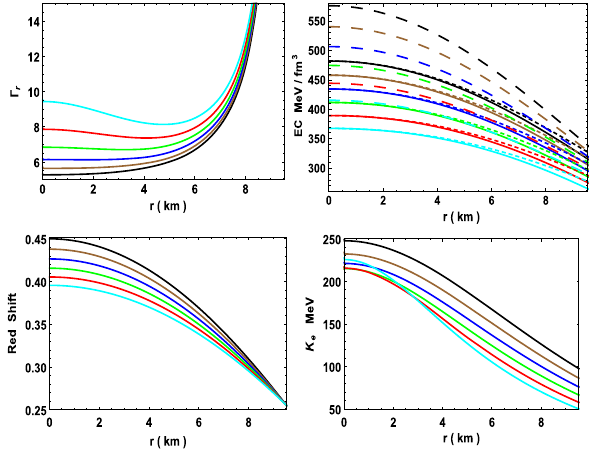
Fig. 21 Variation of Γ r , energy condition (EC) ( p r + ρ − solid, p t + ρ − small dashed, p + 2 p + ρ − dashed), redshift and compression r t modulus with radial coordinate r for 4U 1608-52 ( M = 1 . 74 M (cid:9) , R = 9 . 528 km) by taking a = 0 . 001 km − 2 and n = 3. We are using the same color notation in all the graphs from Figs. 19, 20 and 21 as β = 0 (black),0.014(brown),0.028(blue),0.042(green),0.056(red)and0.07